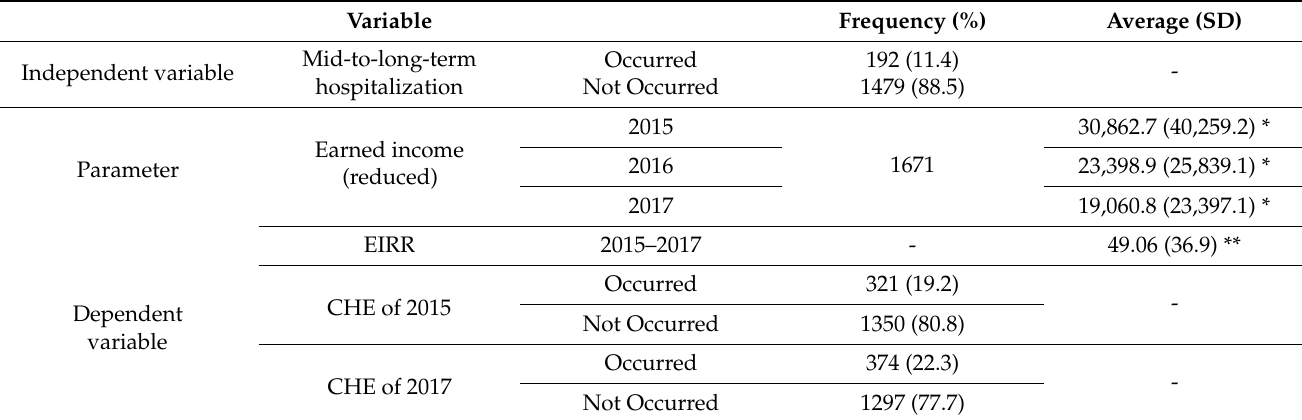
Table 2. Descriptive statistics of key